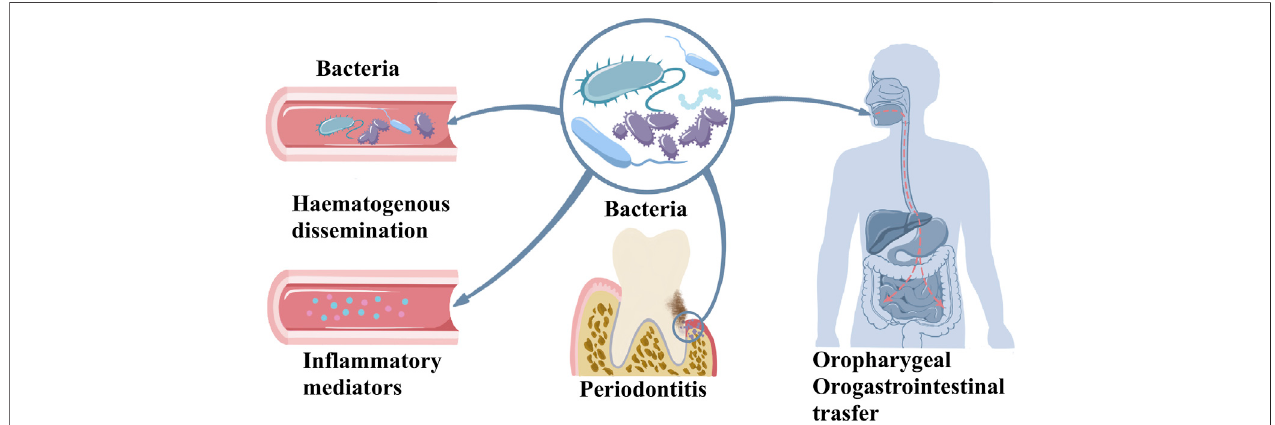
FIGURE 1 | The possible route of systemic effects of